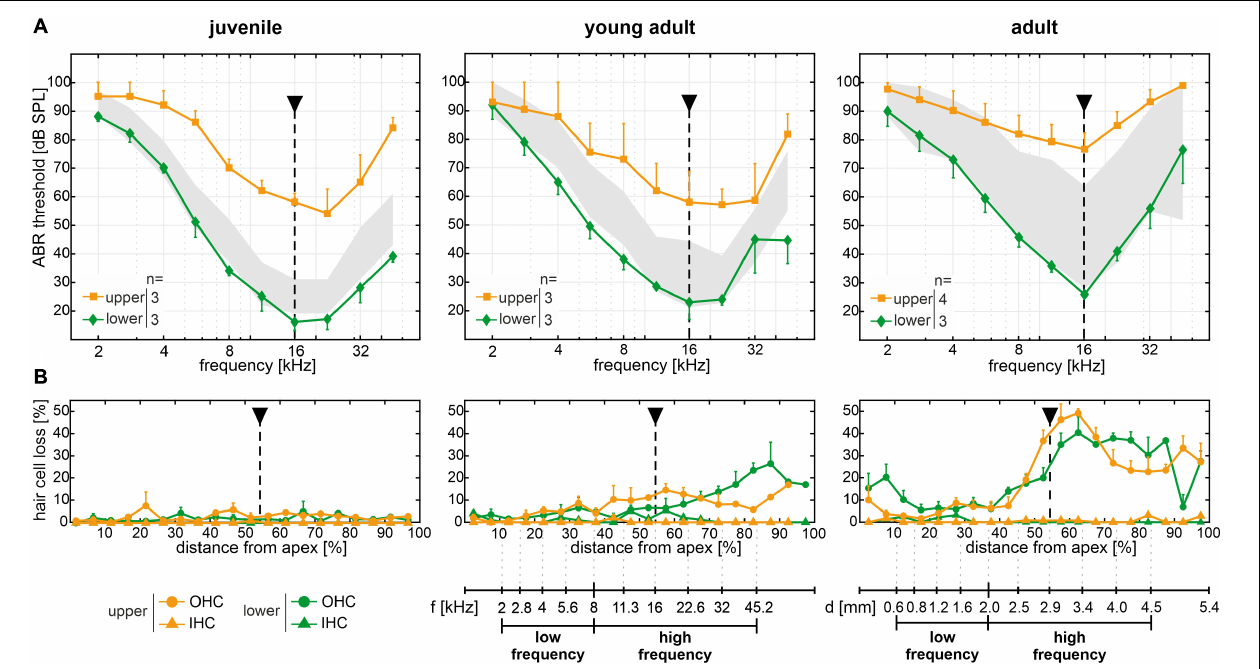
FIGURE 5 | Spatiotemporal analysis of cochlear hair cell loss over age of the experimental cohort. (A) Mean and SEM of auditory brainstem response (ABR) thresholds of ears corresponding to the whole-mount analysis for each mouse, for mice allocated to the lower (green diamonds) and upper (orange squares) quartiles in each age group (juvenile, young adult, and adult). The interquartile range of ABR thresholds of the reference cohort for each age group is shown for comparison (gray area, see Figure 2 ). (B) Cytocochleograms showing mean and SEM of outer and inner hair cell loss (OHC as circles and IHC as triangles, respectively) as a function of relative distance from apex, for mice with ABR thresholds allocated to the lower (green) and upper (orange) quartiles, respectively, in each age group. A mouse place-frequency map (Wang et al., 2002; Viberg and Canlon, 2004; Müller et al., 2005) was used to divide cytocochleograms into low- ( ≤ 8 kHz) and high-frequency ( > 8 kHz) ranges. For reference, frequency (f) and cochlear spiral length (d) axes are depicted with respect to the relative distance from apex. The dashed line highlights ABR thresholds and corresponding OHC and IHC loss at 16 kHz, for which the largest mean threshold difference was found in all age